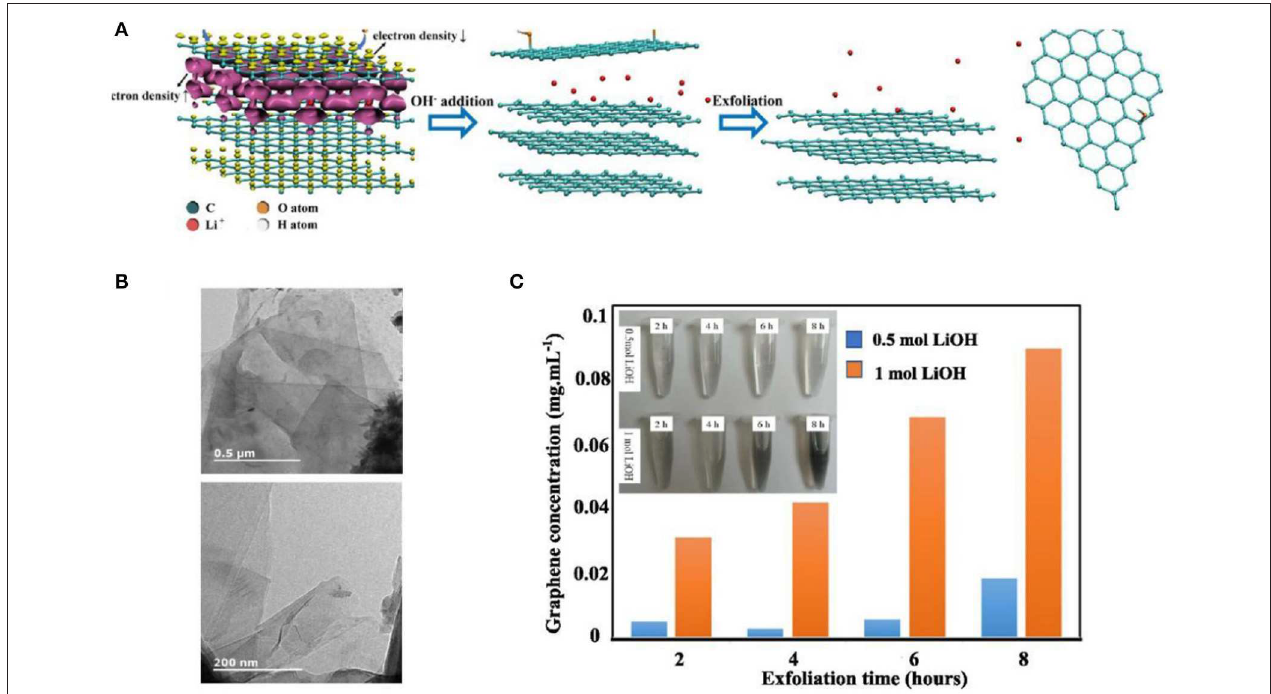
FIGURE 10 | (A) Synthetic strategy diagram of the Li + -OH − stripping system. The purple and yellow surfaces in the left image represent the e/Bohr 3 isosurfaces of the electron density difference caused by Li + embedding. (B) Transmission electron microscopy (TEM) image of the exfoliated graphene sheet. (C) Relationship between the concentration of graphene and the synergistic effect of LiOH and the peeling time. The inset is a prepared aqueous graphene suspension.